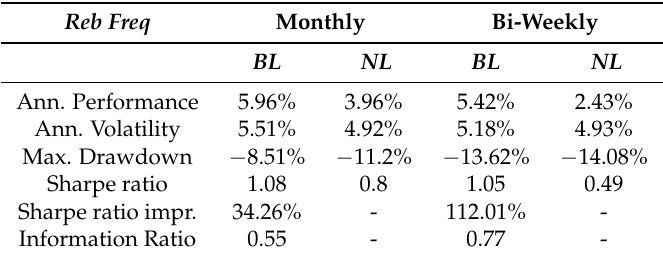
Table 7. Statistics for BL and NL strategies with different rebalancing frequencies Reb Freq , monthly versus biweekly. The Sharpe ratio improvement is calculated as the relative difference between BL and NL Sharpe ratios for the same rebalancing